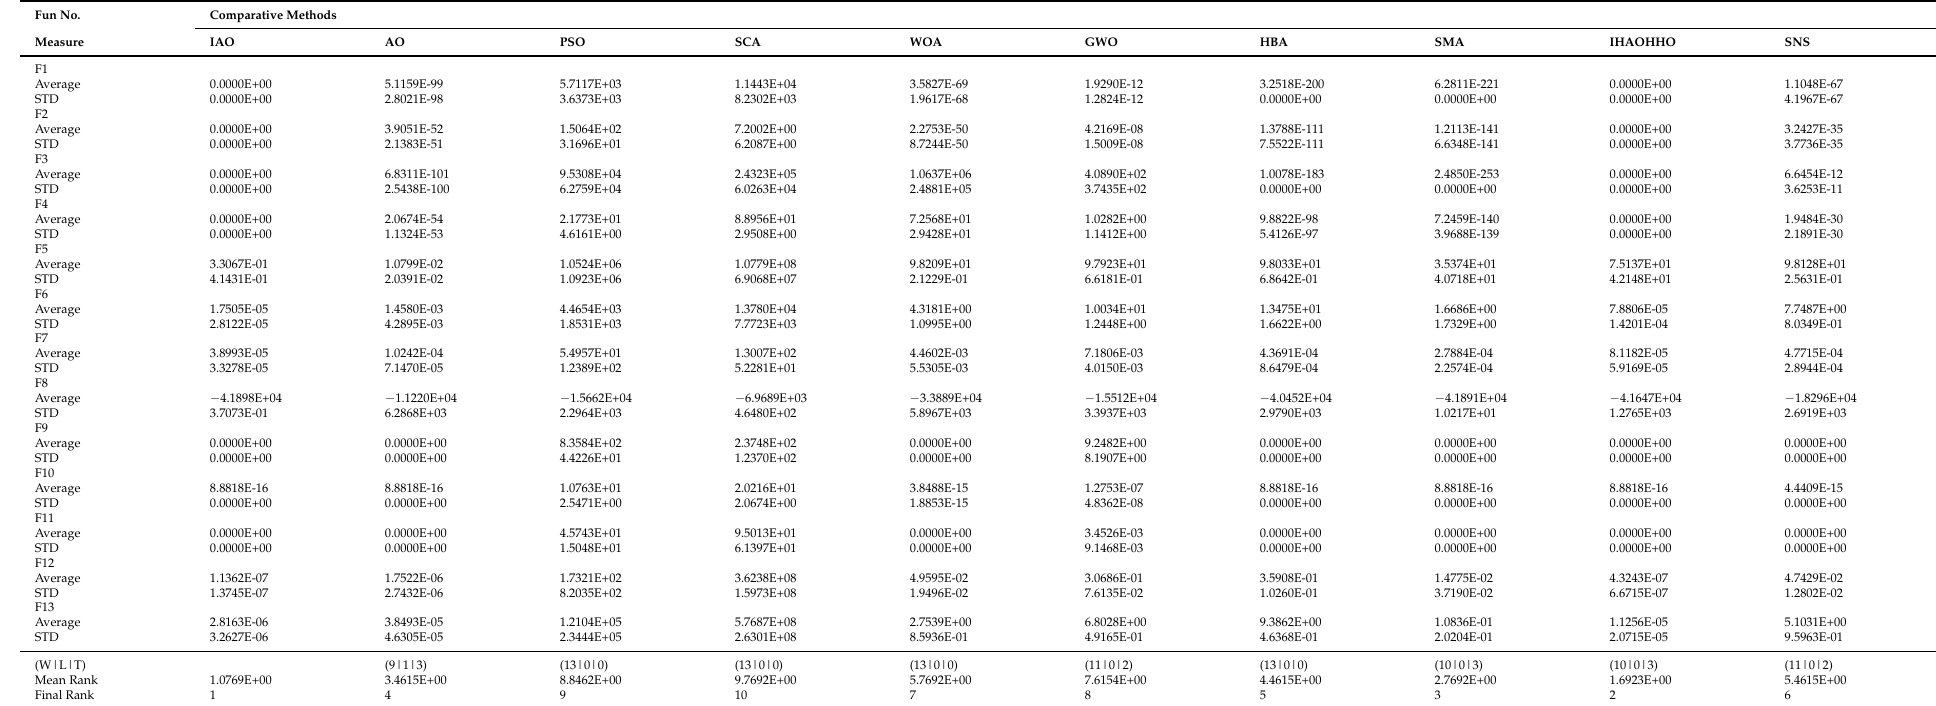
Table 7. Results of the comparative methods on classical test functions (F1–F13); the dimension is fixed to 100.